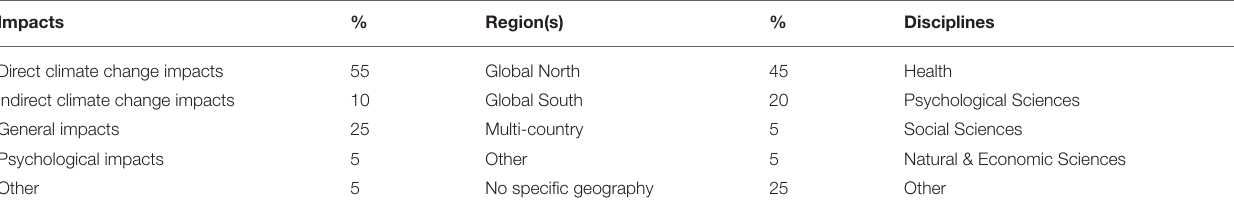
TABLE 3 | Impacts, regions, and disciplines represented in the 165 papers from Search A.